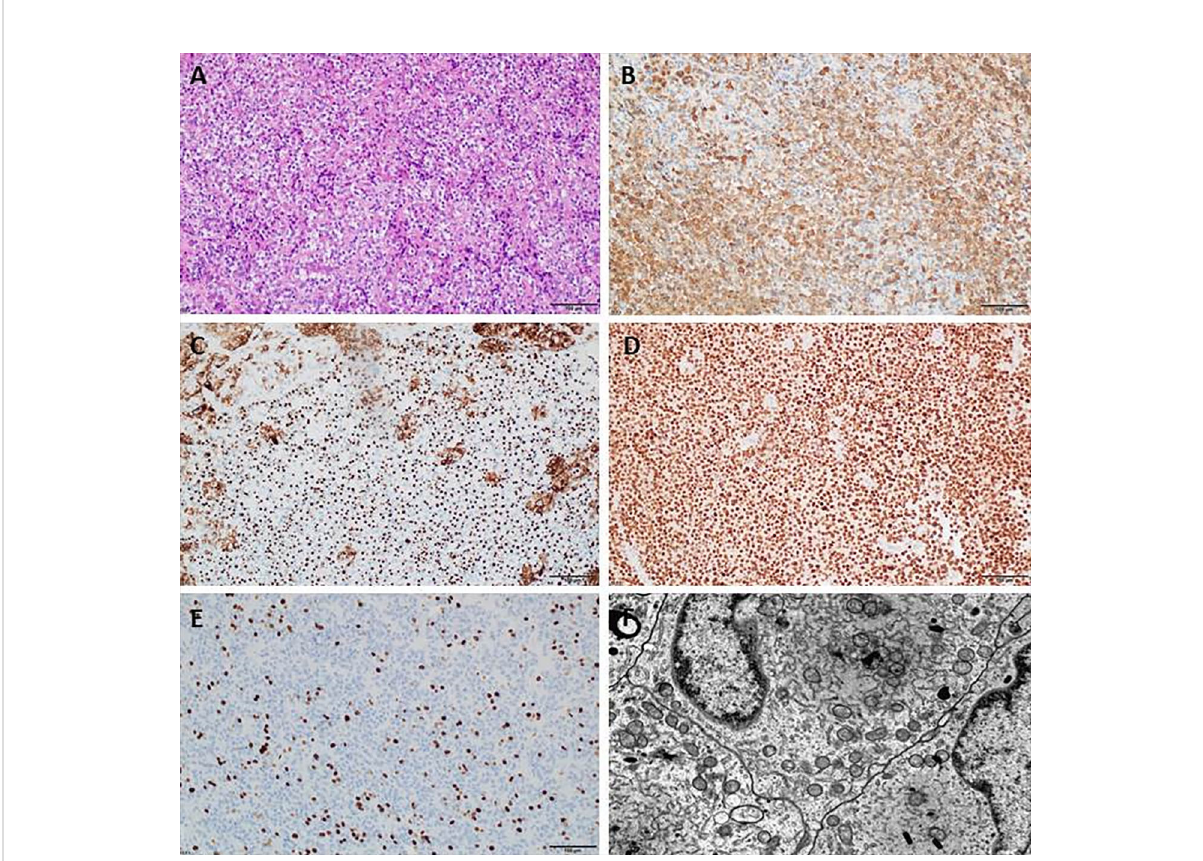
FIGURE 3 Sparsely granulated somatotroph pituitary adenoma (PitNET). (A) Histology of sparsely granulated somatotroph PitNET (HE), (B) Immunopositive staining for growth hormone (GH), (C) Immunopositive staining for Cam5.2, (D) Immunopositive staining for PIT1, (E) Immunopositive staining for Ki-67, (F) Ultrastructural features of sparsely granulated somatotroph